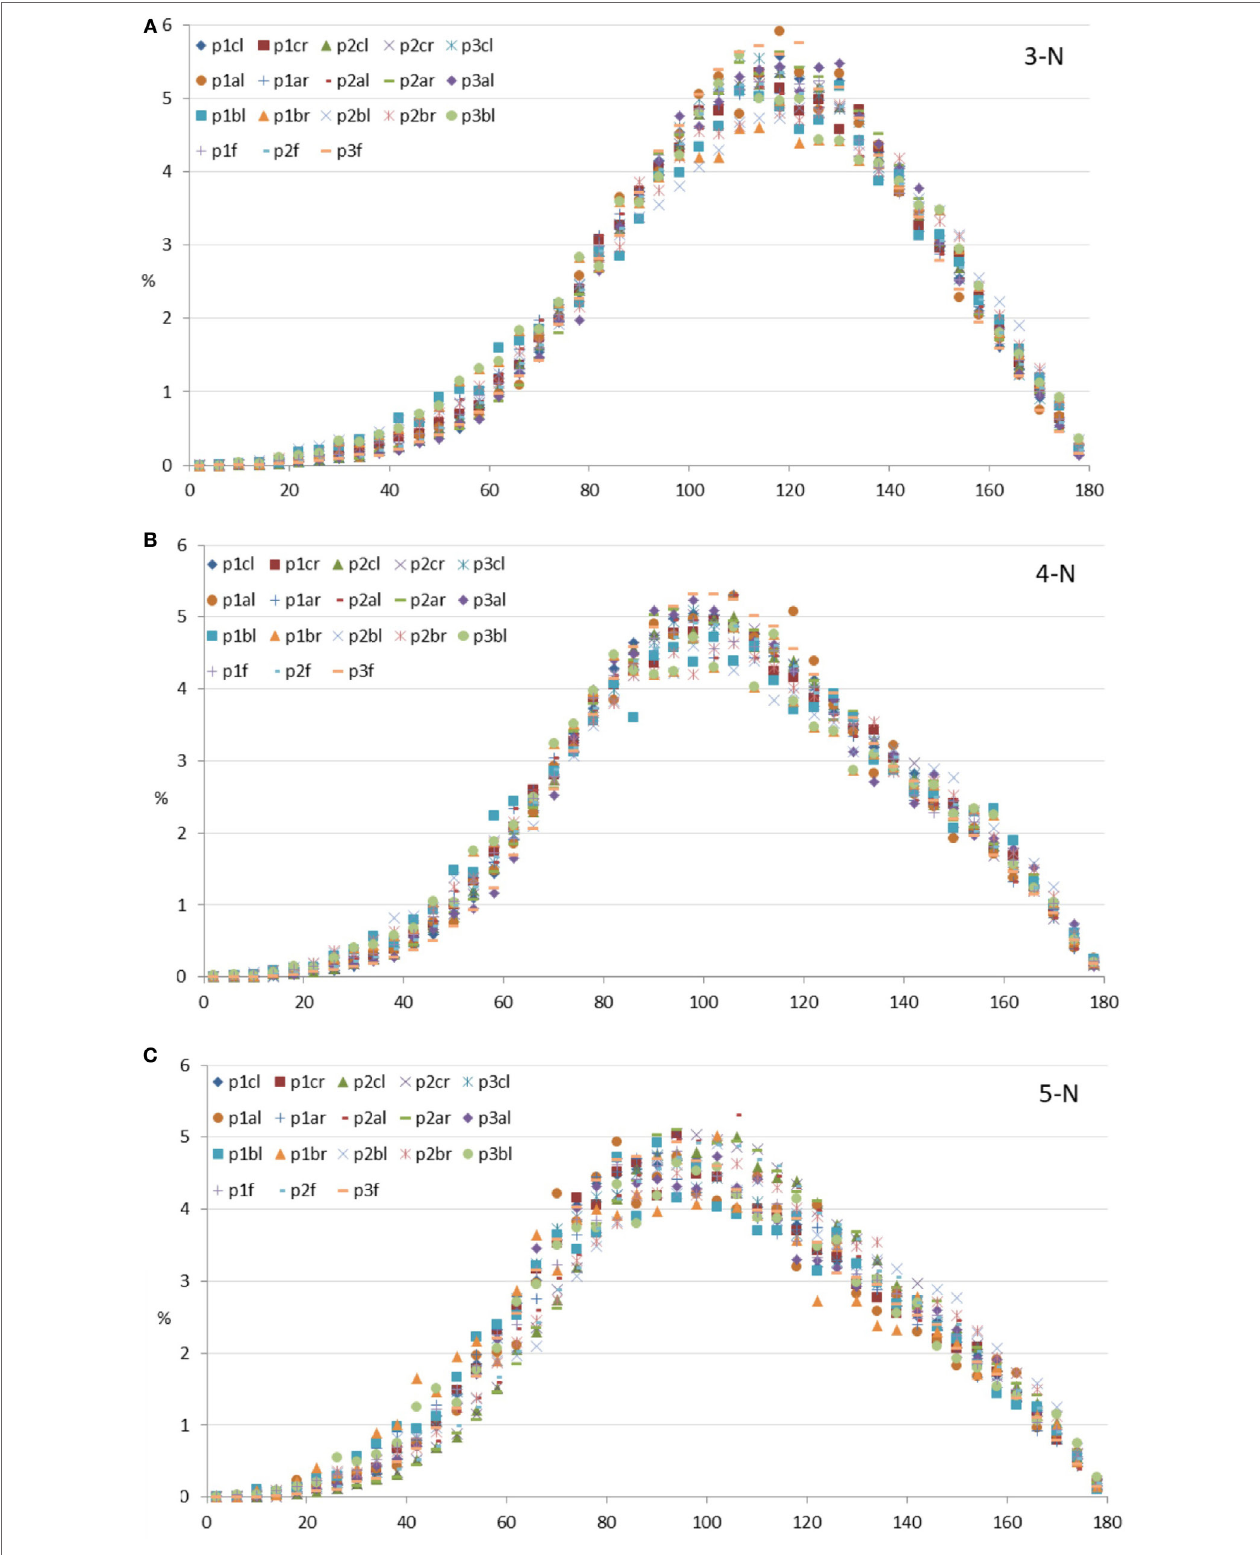
FigUre 6 | Inter-trabecular angle (ITA) distributions of all specimens measured per node type. Frequencies of binned ITA values are given in percent of the total number measured; horizontal axes show ITA values in degrees. (a) 3-N nodes; (B) 4-N nodes; (c) 5-N nodes. Legends: first row, all condyles; second row, all mandibular angles; third row, all mandibular bodies; fourth row, all pig femoral